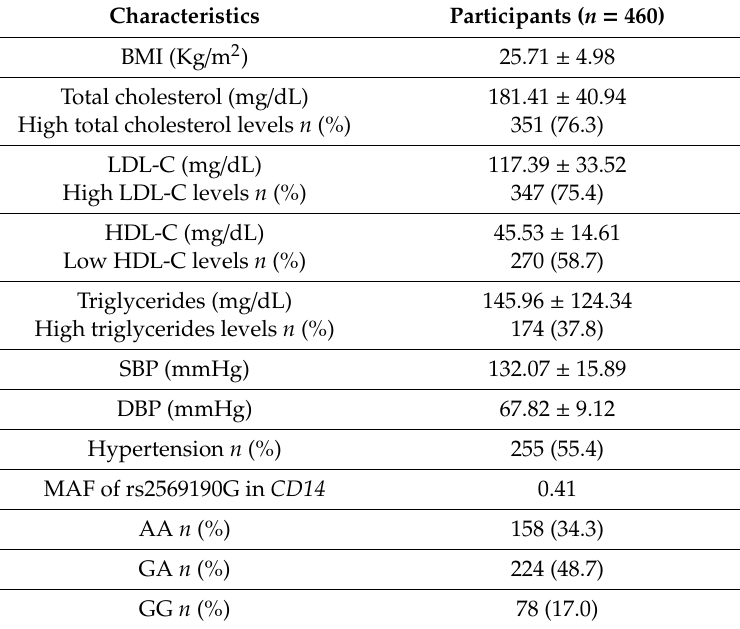
Table 2. Clinical and genetic characteristics of the study